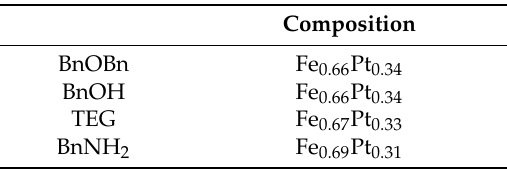
Table A2. Stoichiometry of the fcc-FePt nanocrystals as determined by ICP-OES (Fe content) and ICP-MS (Pt content).